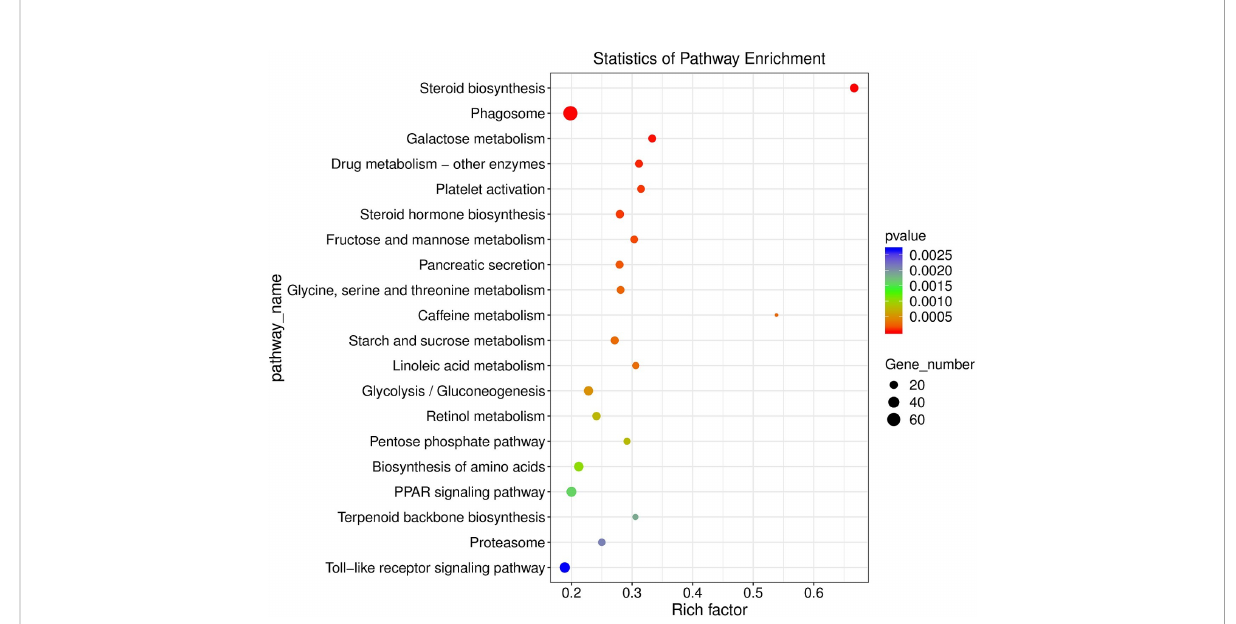
FIGURE 2 KEGG enriched pathways (top 20, p < 0.05) scatter plot of signi fi cantly differentially expressed genes in juvenle fl ounder under MeHg